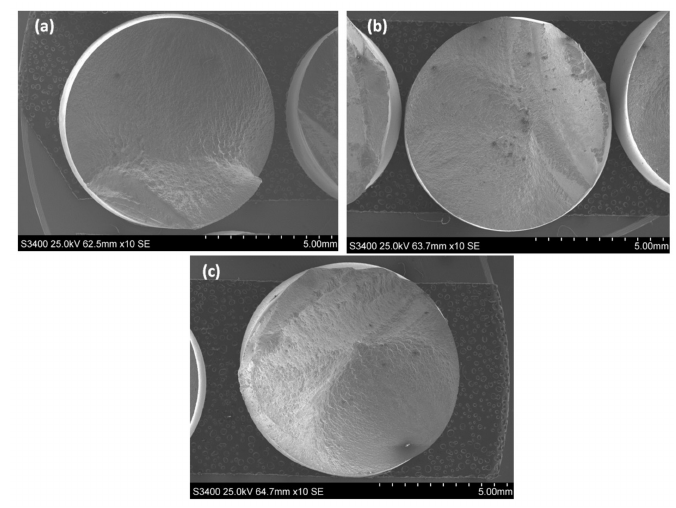
Figure 7. Specimen microscopic cross-section fractures, showing initiation in the surface for the following cases: ( a ) R = − 2; σ a = 440 MPa; σ m = 0 MPa; N cycles = 986,700; ( b ) R = − 1; σ a = 430 MPa;